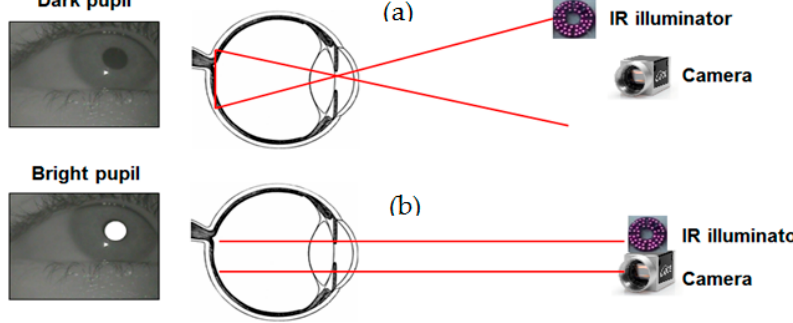
Figure 2. infrared (IR) illuminator location around eye capture camera. ( a ) Dark pupil effect; ( b ) Bright pupil